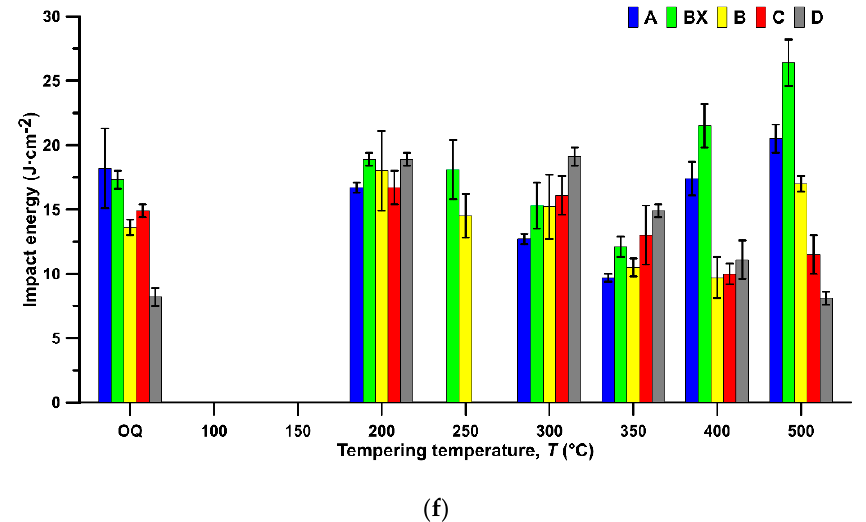
Figure 4. Mechanical properties of samples after quenching and tempering up to the temperature of 500 °C. ( a ) UTS—ultimate tensile strength; ( b ) YS—yield strength; ( c ) A5—elongation; ( d ) Z— reduction of area; ( e ) hardness; ( f ) Charpy impact energy of samples after quenching and tempering.